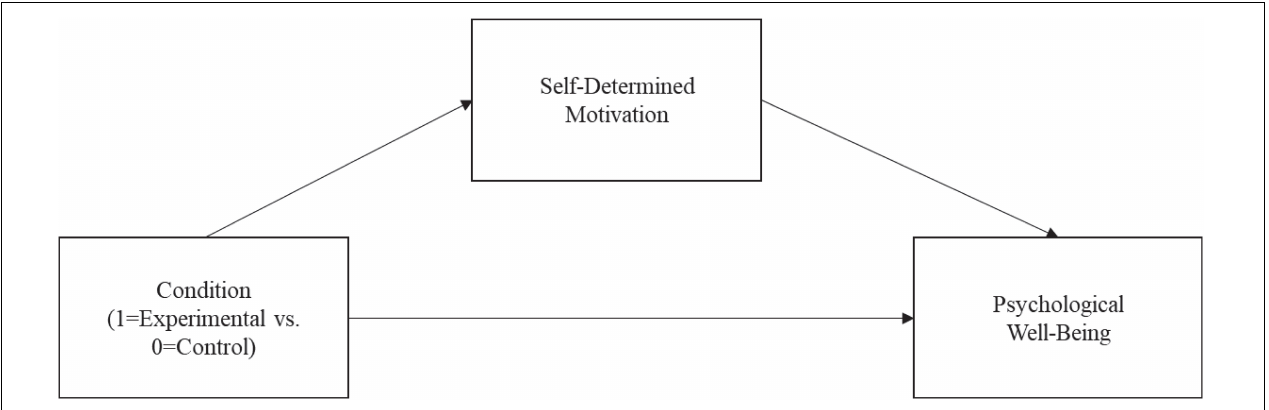
FIGURE 1 | Proposed mediation model testing the role of a self-determined motivation to encourage learning and having fun in hockey in mediating the association between the experimental condition and psychological well-being.